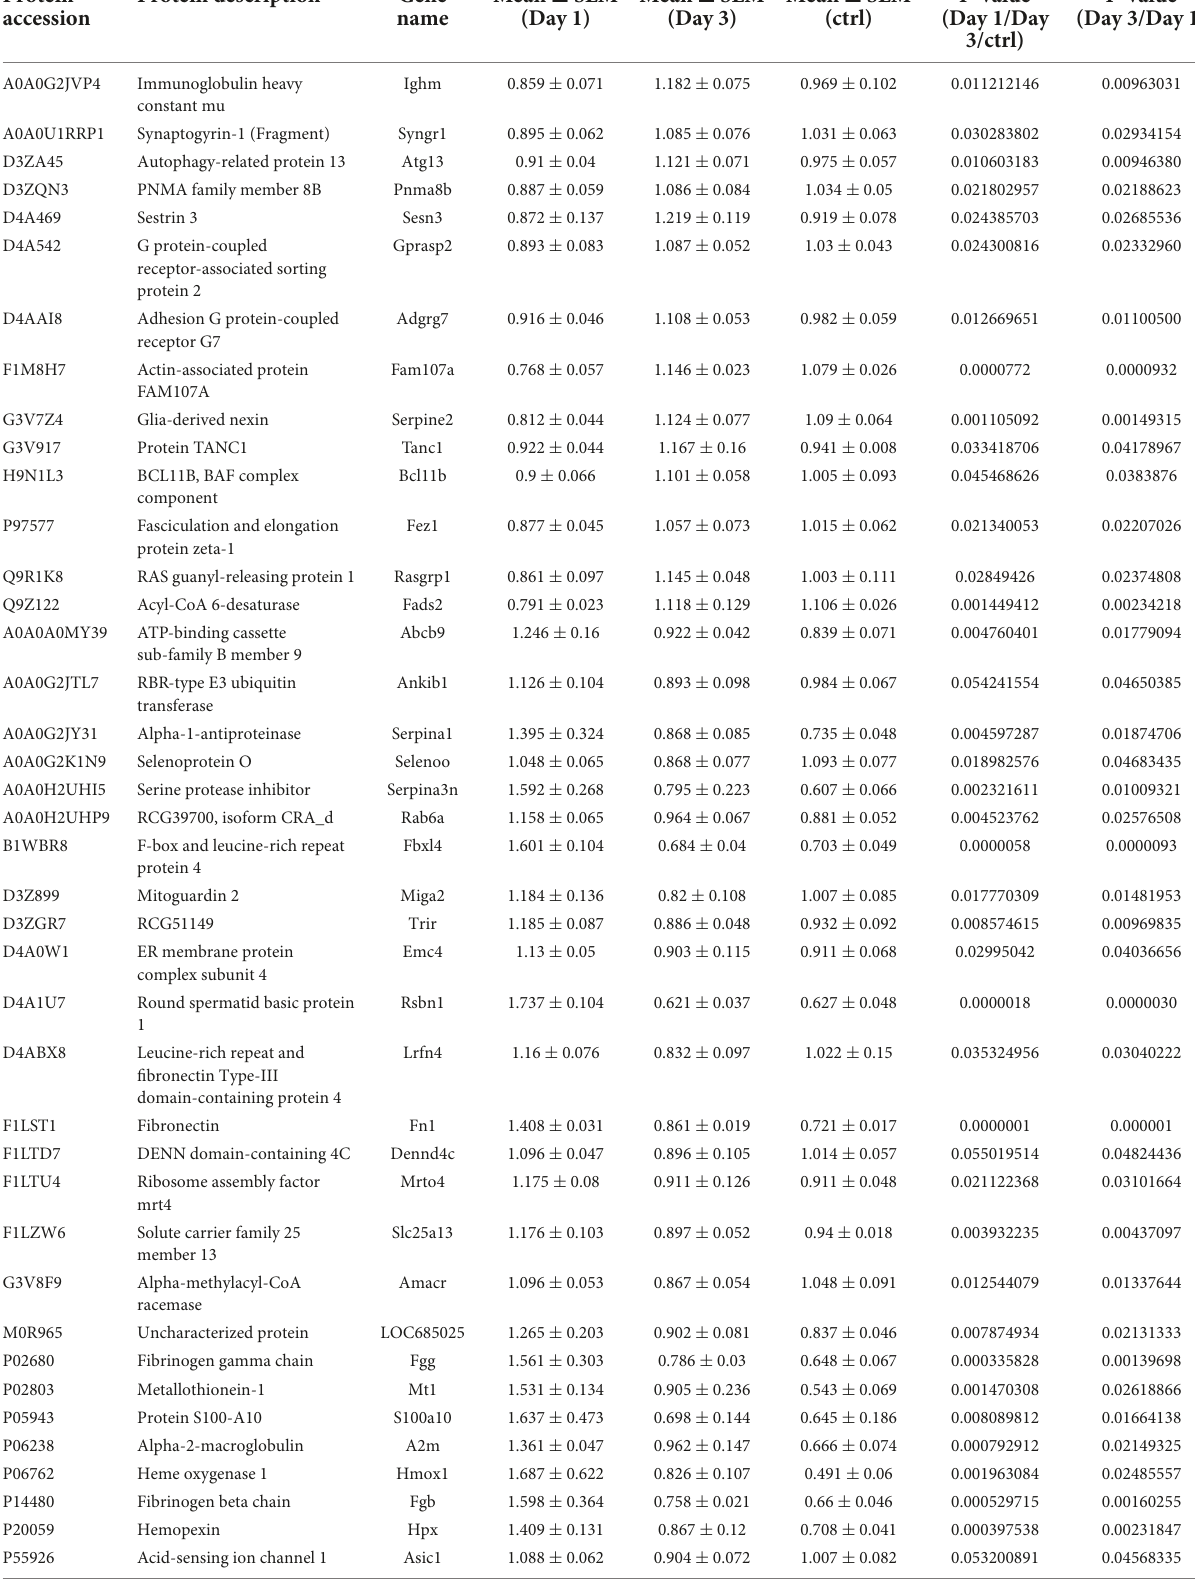
TABLE 3 Differentially expression proteins on Day 3 comparing with Day 1 in hippocampus post ANOVA analysis. Protein